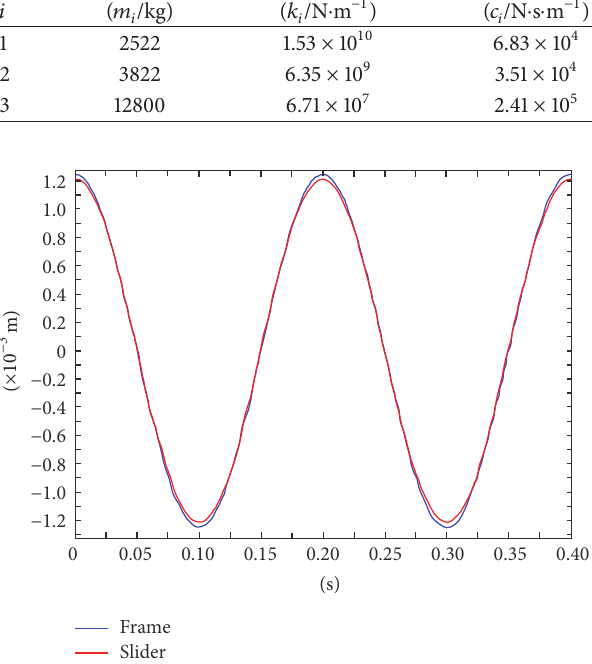
Figure 4: Analytical curves of the vibration of the slider and frame under the zero-load operating